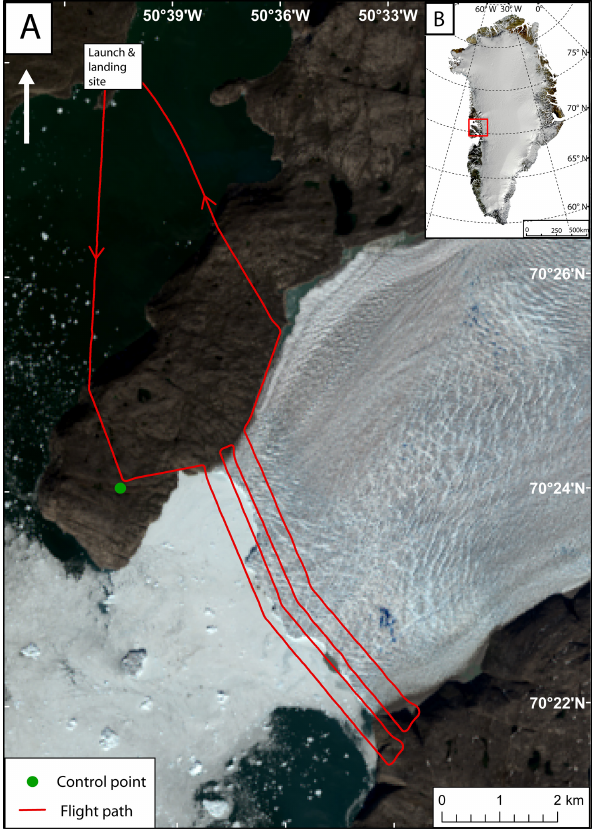
Figure 1. (a) A typical UAV sortie over Store Glacier. The back- ground map is a Landsat 8 true colour image from 12 June 2013. The red line shows the UAV flight path on the 2 July 2013. (b) Lo- cation of Store Glacier in the Uummannaq region, West Greenland on a MODIS mosaic image of Greenland (Kargel et al.,